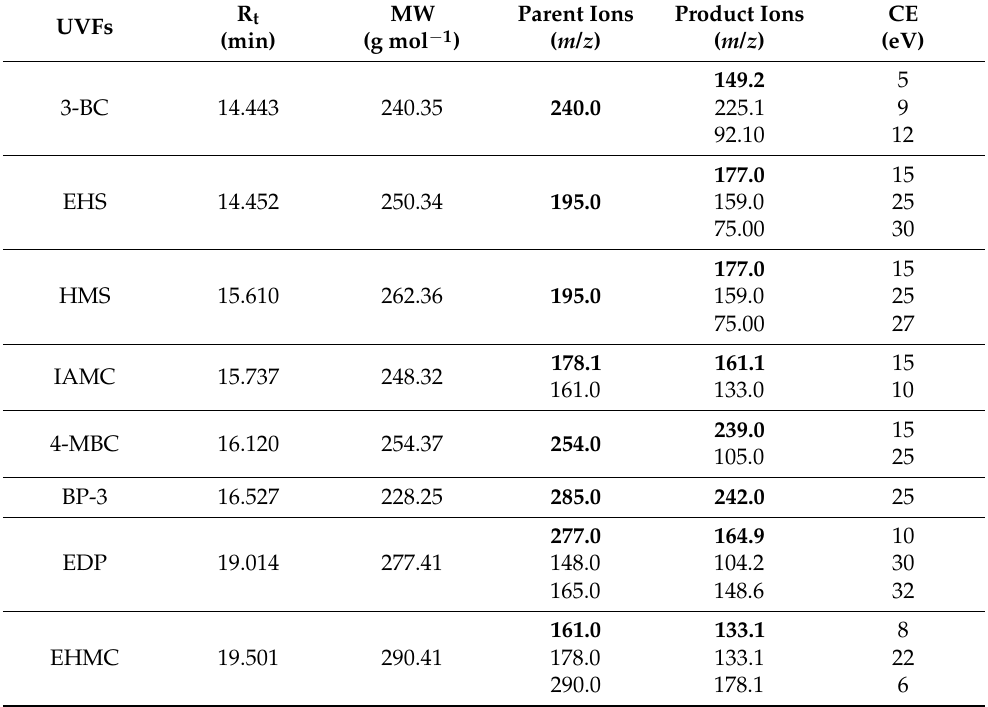
Table 2. Experimental GC–MS/MS parameters of